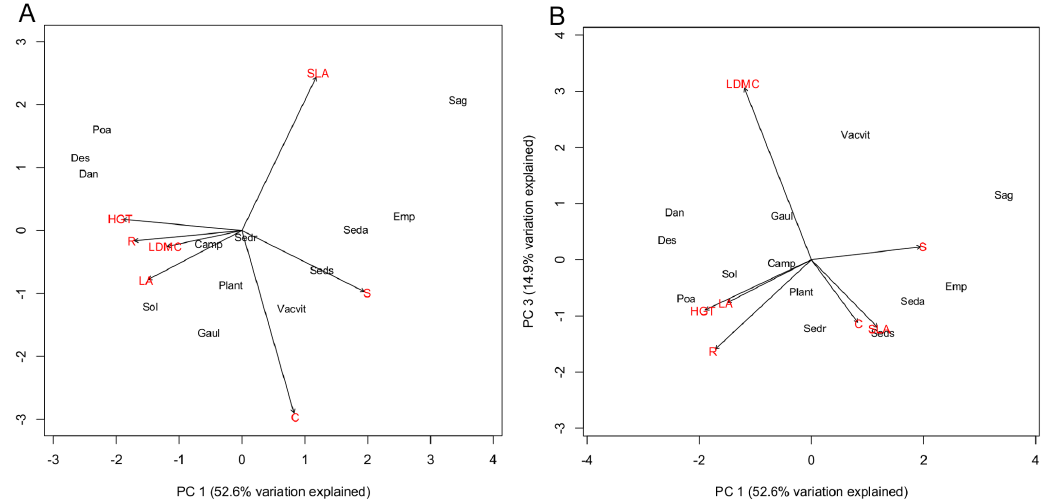
Figure 4. Principal components analysis of species, by leaf traits and life history variables. Species abbreviations: Poa=P. compressa; Des=D. flexuosa; Dan=D. spicata; Traits in red: SLA=specific leaf area; LA=leaf area; LDMC=leaf dry matter content; HGT=plant height; R=ruderal score; S=stress-tolerance score; C=competitive score.